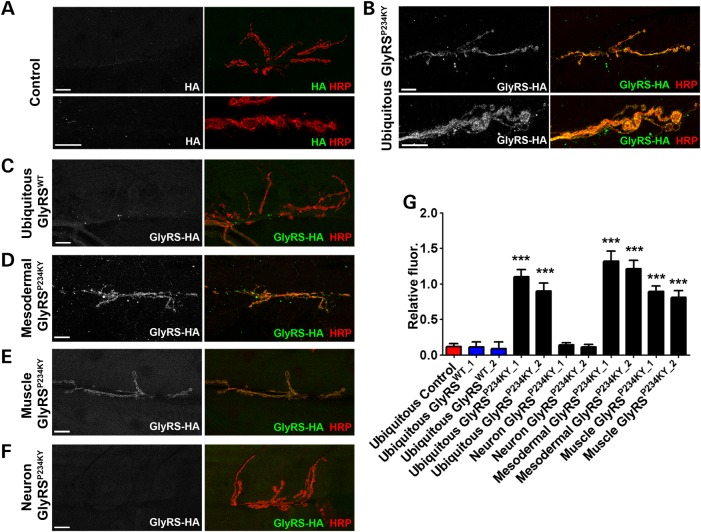
GlyRSP234KY secretion leads to non-cell autonomous build-up at the neuronal membrane. (A–F) L3 larval NMJs were stained under non-permeabilization conditions to assess GlyRSP234KY binding to the neuronal extracellular membrane. (A) HA staining was not observed at the membrane in control flies. (B) Ubiquitous garsP234KY expression, but not (C) garsWT expression, leads to a build-up of GlyRS at the neuronal membrane. (D) Mesodermal and (E) muscle expression of garsP234KY also causes a build-up of GlyRSP234KY on the neuronal membrane. GlyRSP234KY appeared to associate with the whole pre-synapse and axonal regions. (F) Neuronally expressed GlyRSP234KY did not localize to the synapse. (G) Quantification of the HA fluorescence at the synapse. Ten NMJs were analysed per genotype. Scale bars = 10 µm.